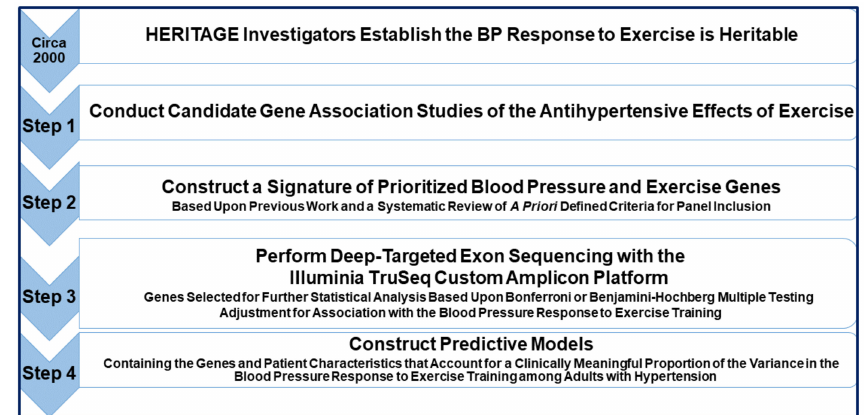
Figure 2. A Systematic review approach to assemble a targeted gene panel to study the genomics of the antihypertensive e ff ects of exercise. HERITAGE: HE alth, RI sk Factors Exercise T r A ining and Ge netics; BP: blood